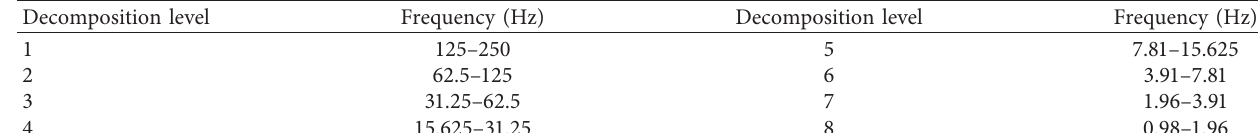
Table 2: Frequency of each decomposition level.